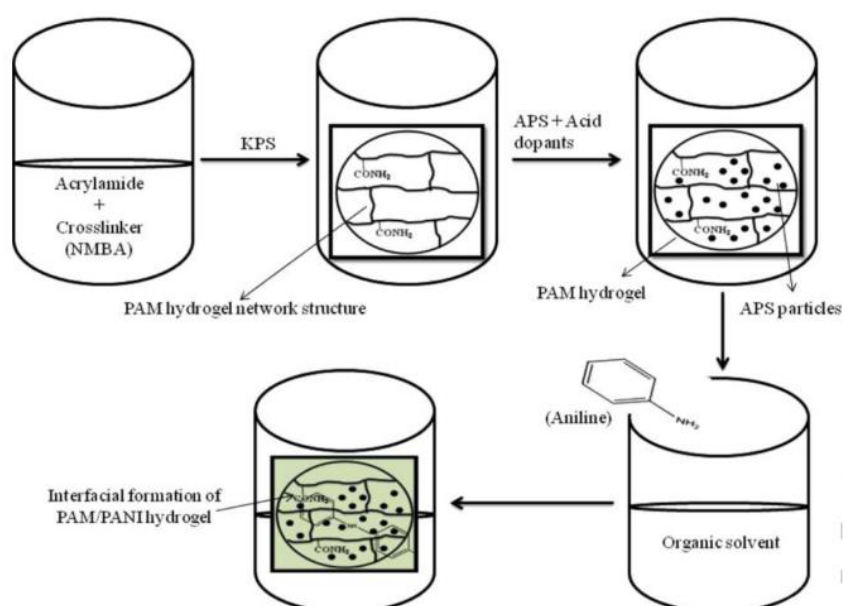
Figure 3. Schematic of PAM and polyacrylamide/PANI hydrogel [62]. Copyright: Taylor & Francis.